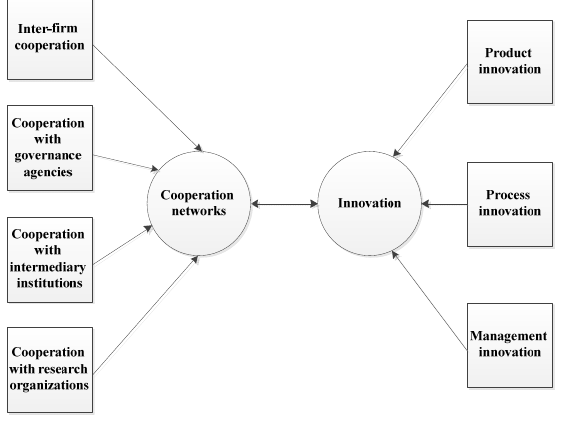
Fig. 1. Research proposed model